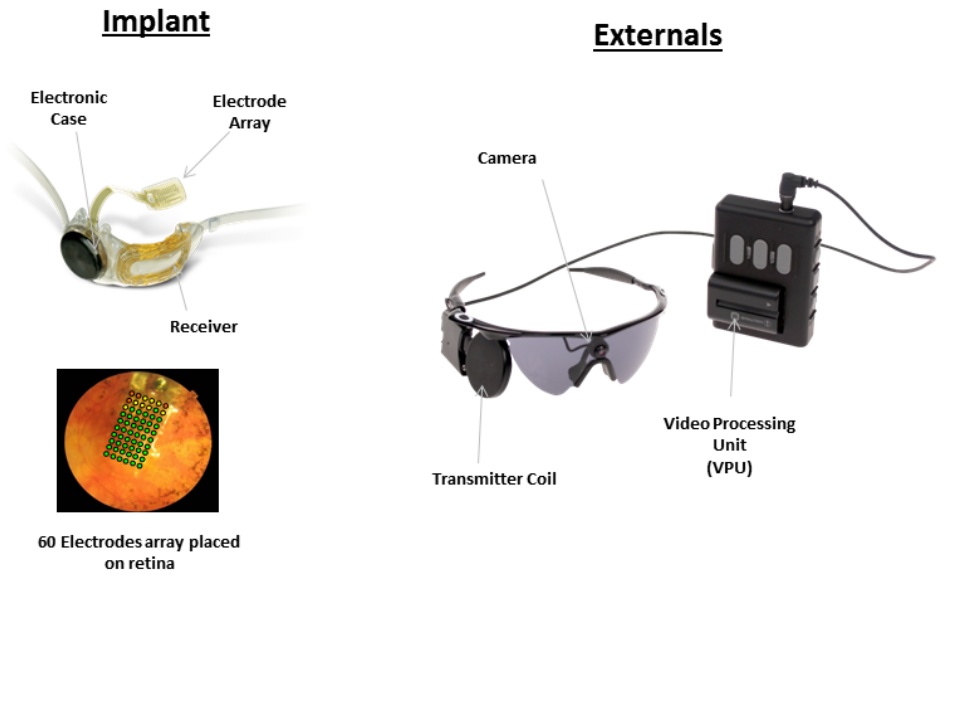
Figure 1. Argus II retinal prosthesis